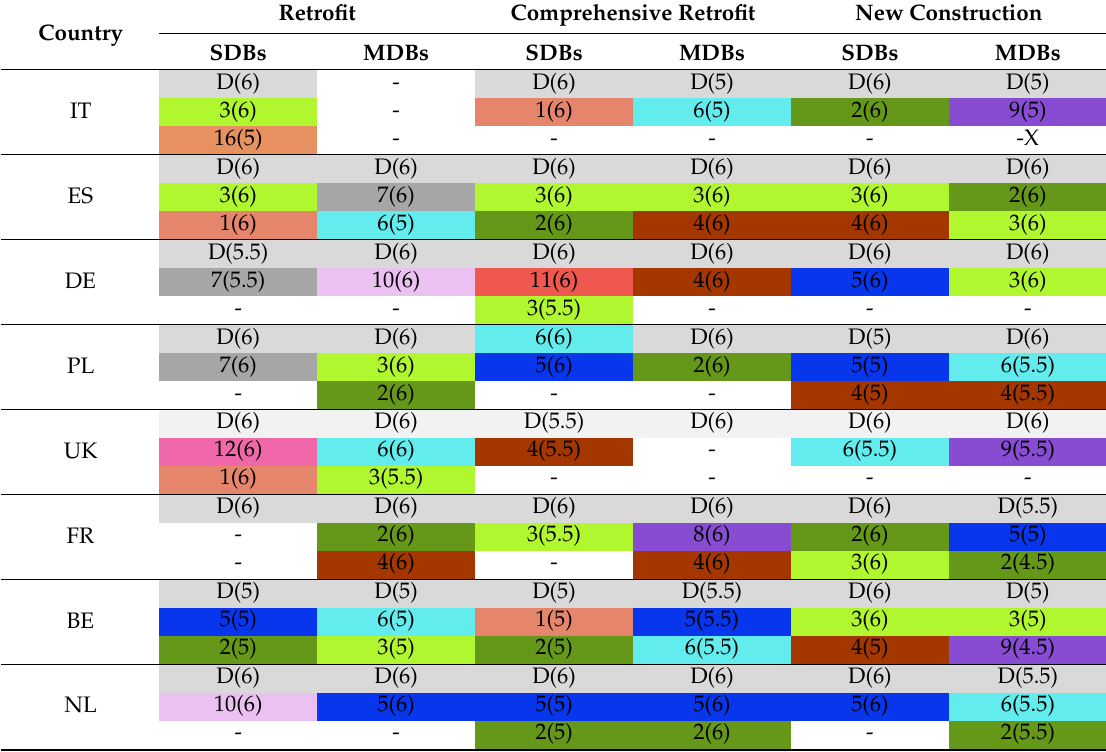
Table 12. Top three stakeholders involved in the selection of the technology decision (classified according to project and country). Retrofit Comprehensive Retrofit New Country